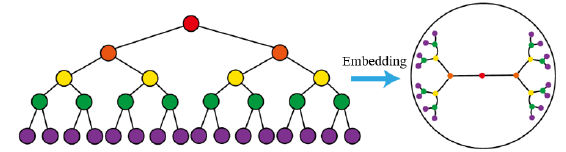
Figure 1. An illustration of tree structure embedding into the hyperbolic